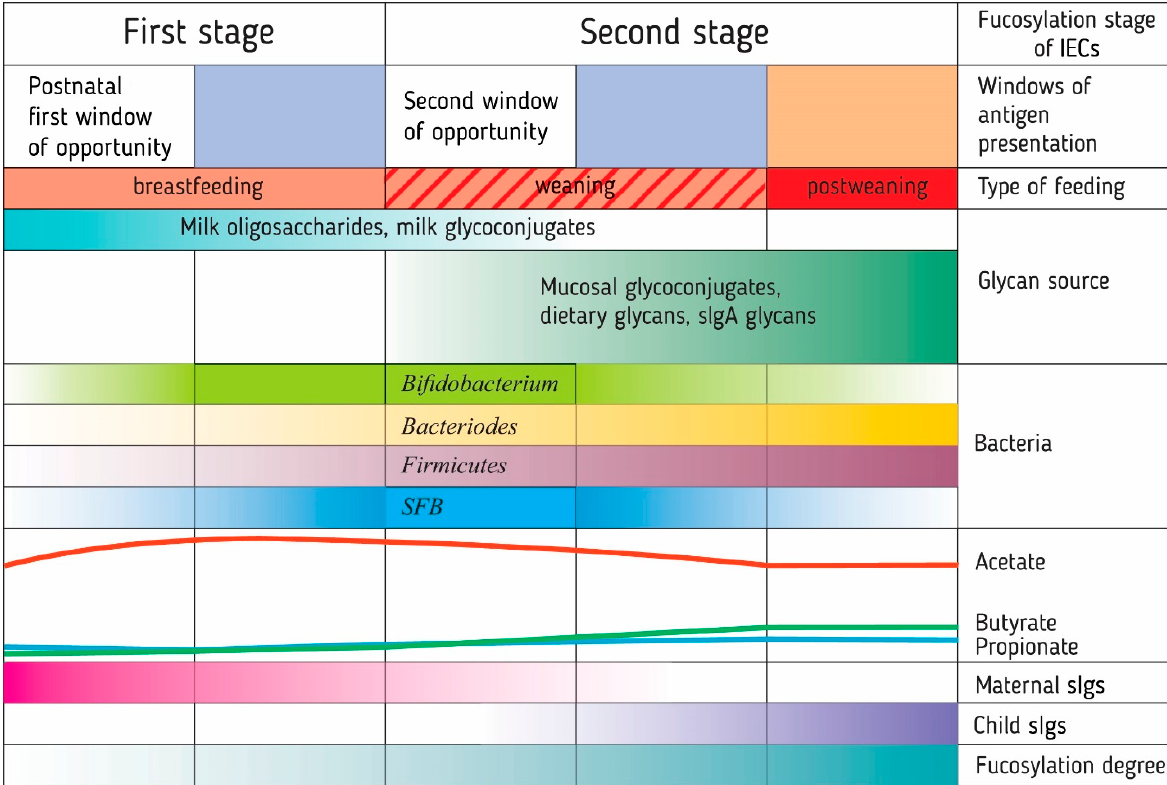
colon lamina propria DCs via goblet cell–associated antigen passages (GAPs) [45] and through microbial metabolites. Both premature and delayed exposure to different micro- organisms have far-reaching health implications and an increased risk of developing dis- eases at an older age, such as allergic and autoimmune diseases, obesity, IBD, and cancer [46–48]. This makes it important to study the mechanisms of the changes in the microbiota and the immune system during this period to understand the causes and mechanisms of non-communicable diseases. The first phase includes the period of breastfeeding from birth to the transition to solid foods. The microbiota at this time is significantly different from that of an adult. Its composition is determined by geographic factors, the presence of siblings and pets, breast milk composition, antibiotics, gestational age, and genetic factors (the latter forms approx- imately 9% of the intestinal microbiota as a polygenic trait) [45]. Lack of breastfeeding, cesarean section, antibiotics use, and eliminating parasitic infections have a large negative effect on the infant’s microbiota [49–51].